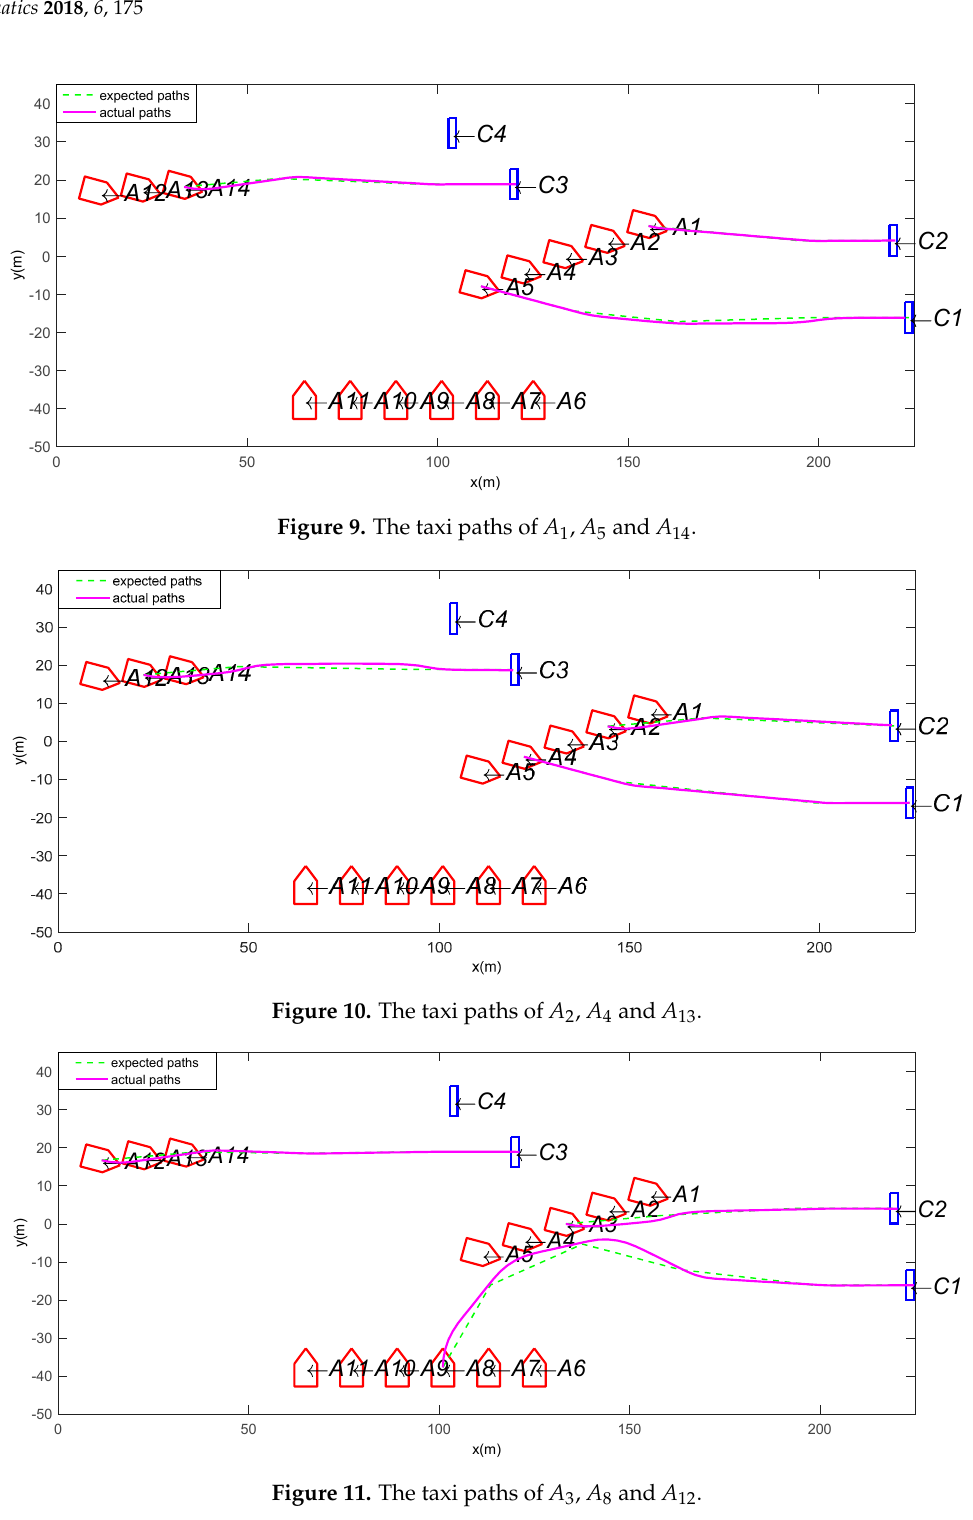
Figure 11. The taxi paths of A 3 , A 8 and A 12.